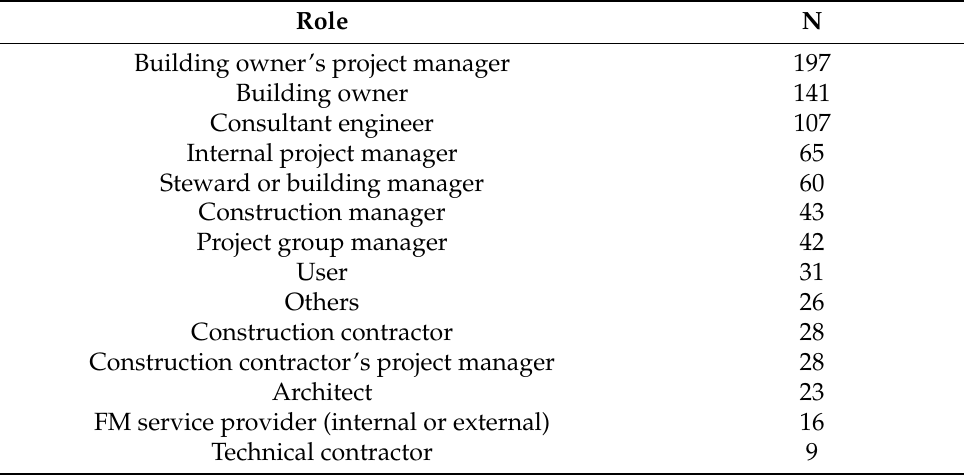
Table 1. The respondents’ roles in their